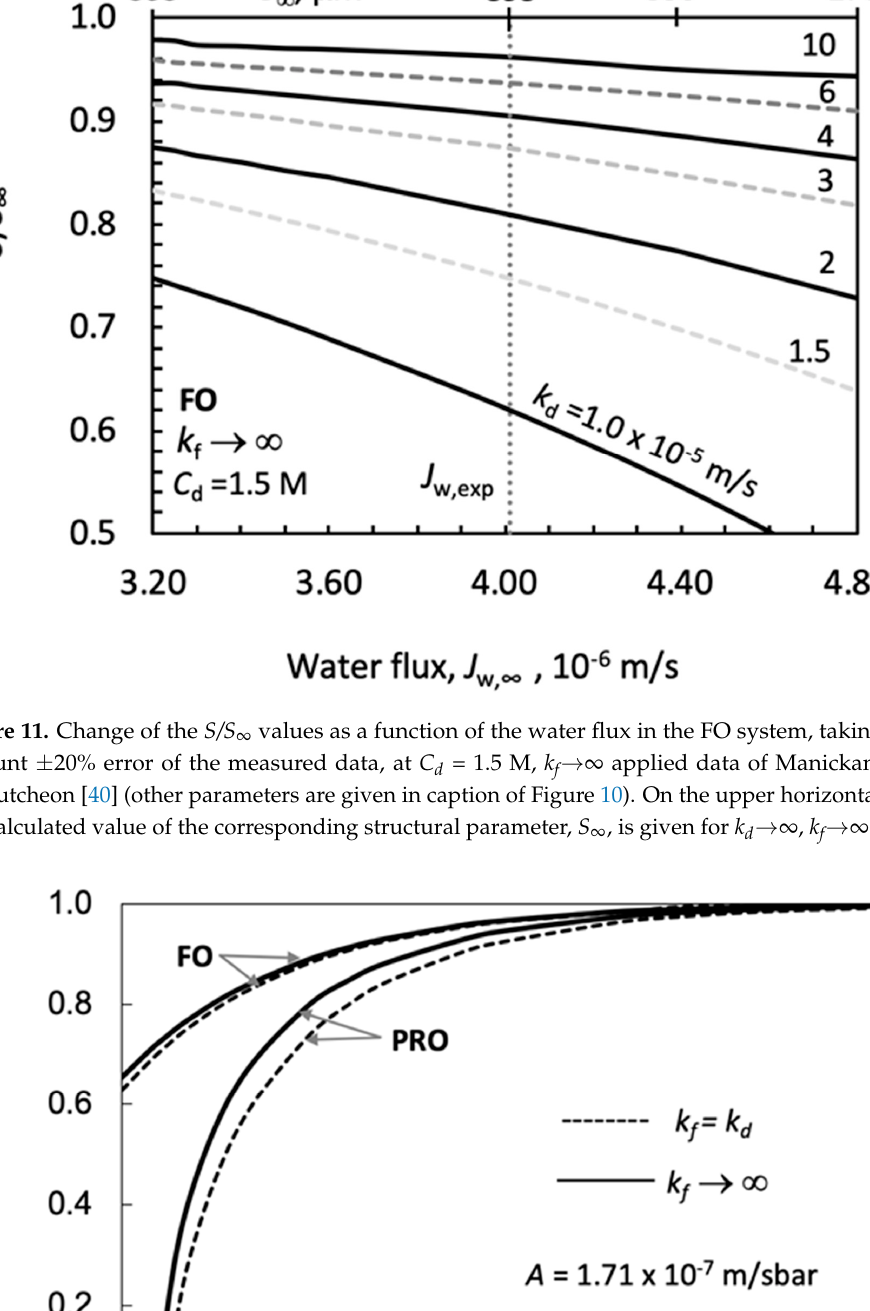
Figure 13. Effect of the water permeability on the value of S/S ∞ and on the water flux, J w , ∞ , as a function of draw side mass transfer coefficient, in a PRO system; C d = 1.0 M; S ∞ = 803 μ m; π d = 43.3 bar; k f → ∞ ; other parameters as they are given in caption of Table 5.